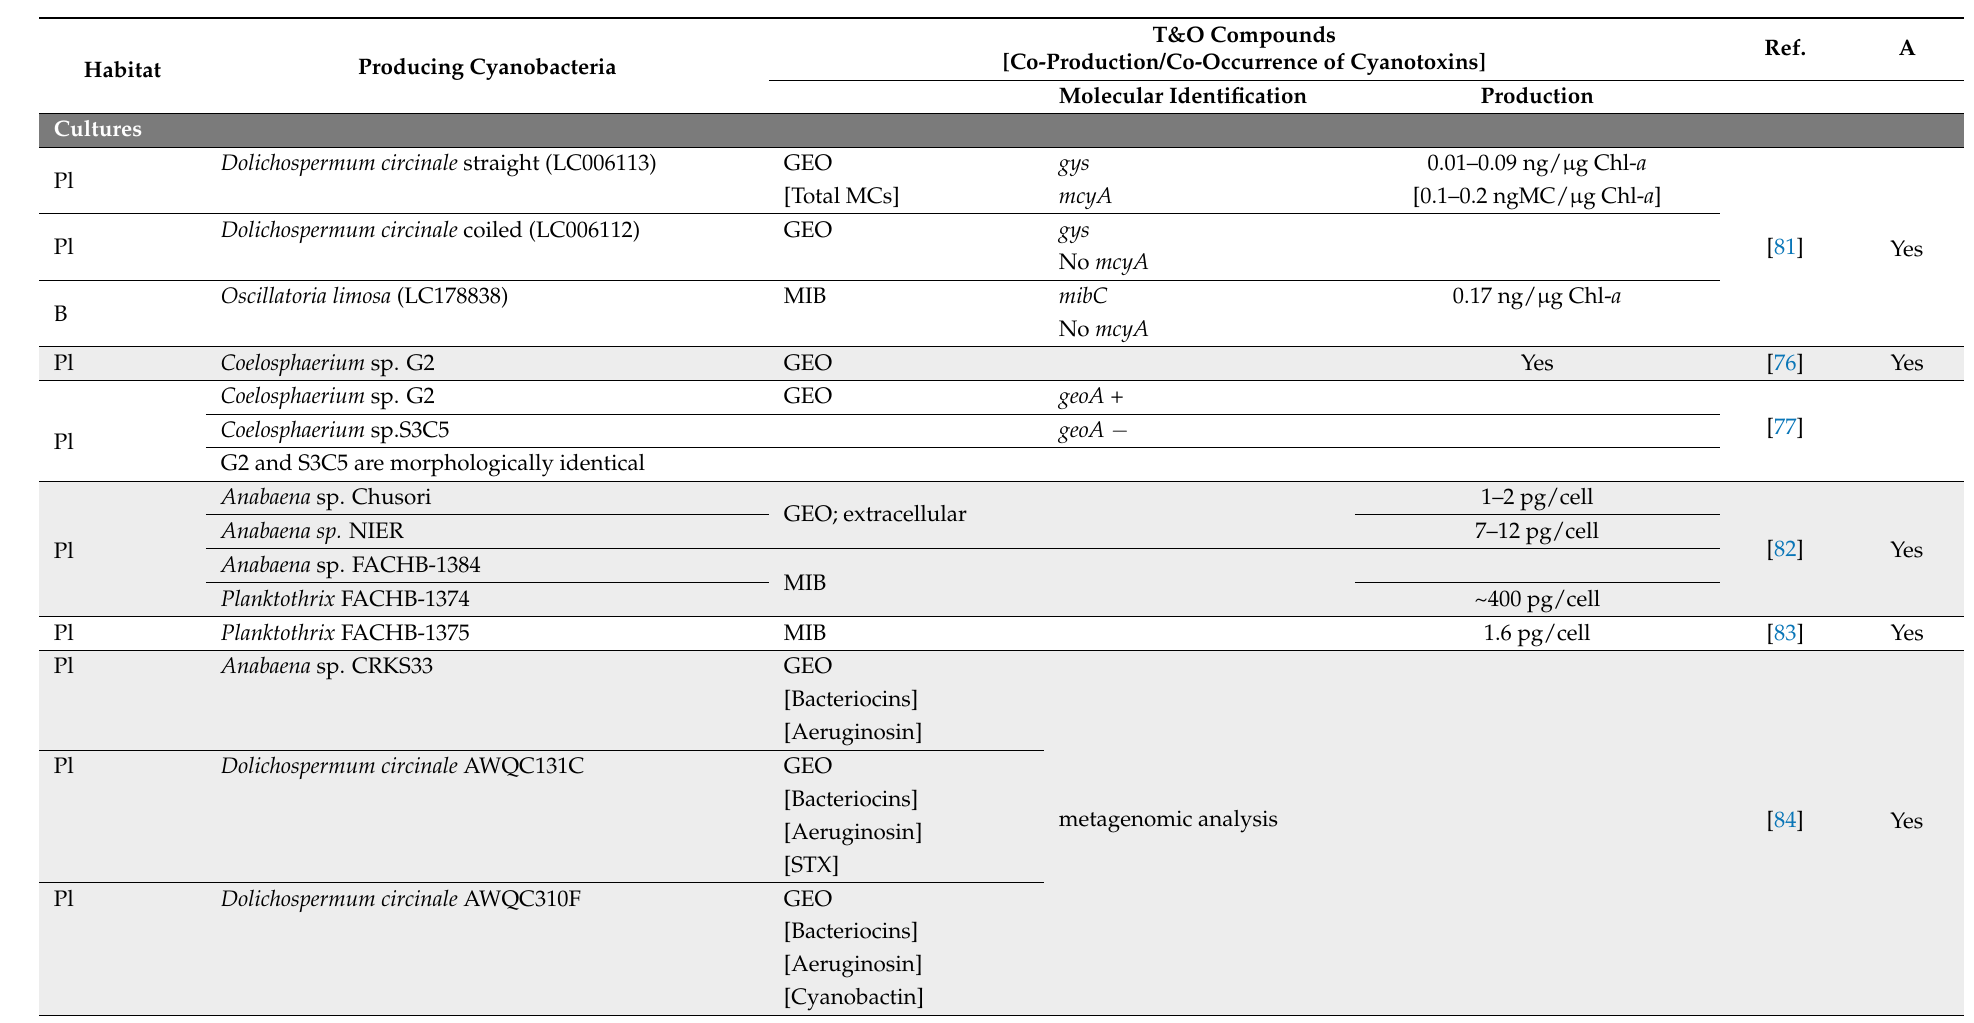
Table 3. Taste and odor compound producers as identified by molecular and/or chemical methods (production), T&O occurrence and co-occurrence of cyanotoxins in cyanobacterial cultures and in field